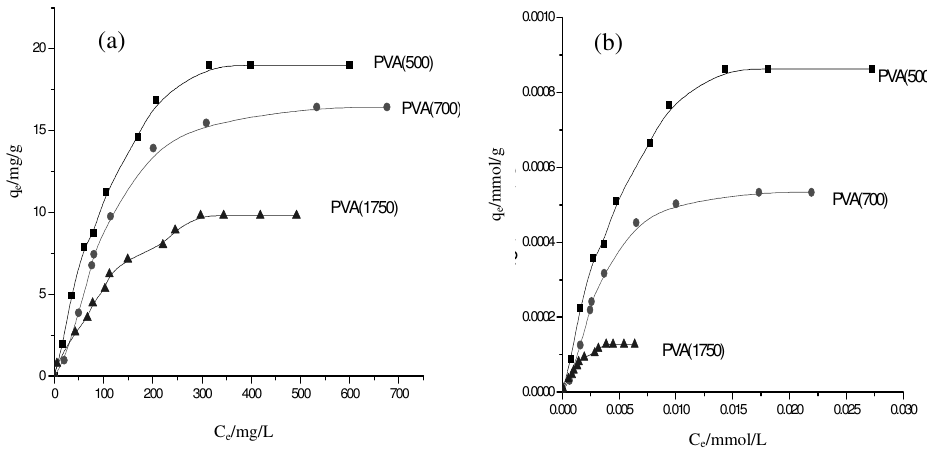
Figure 1. Adsorption isotherm of PVA (500, 700, 1750) at 25 ° C, (a) Unit of adsorbance is mg/g; (b) Unit of adsorbance is